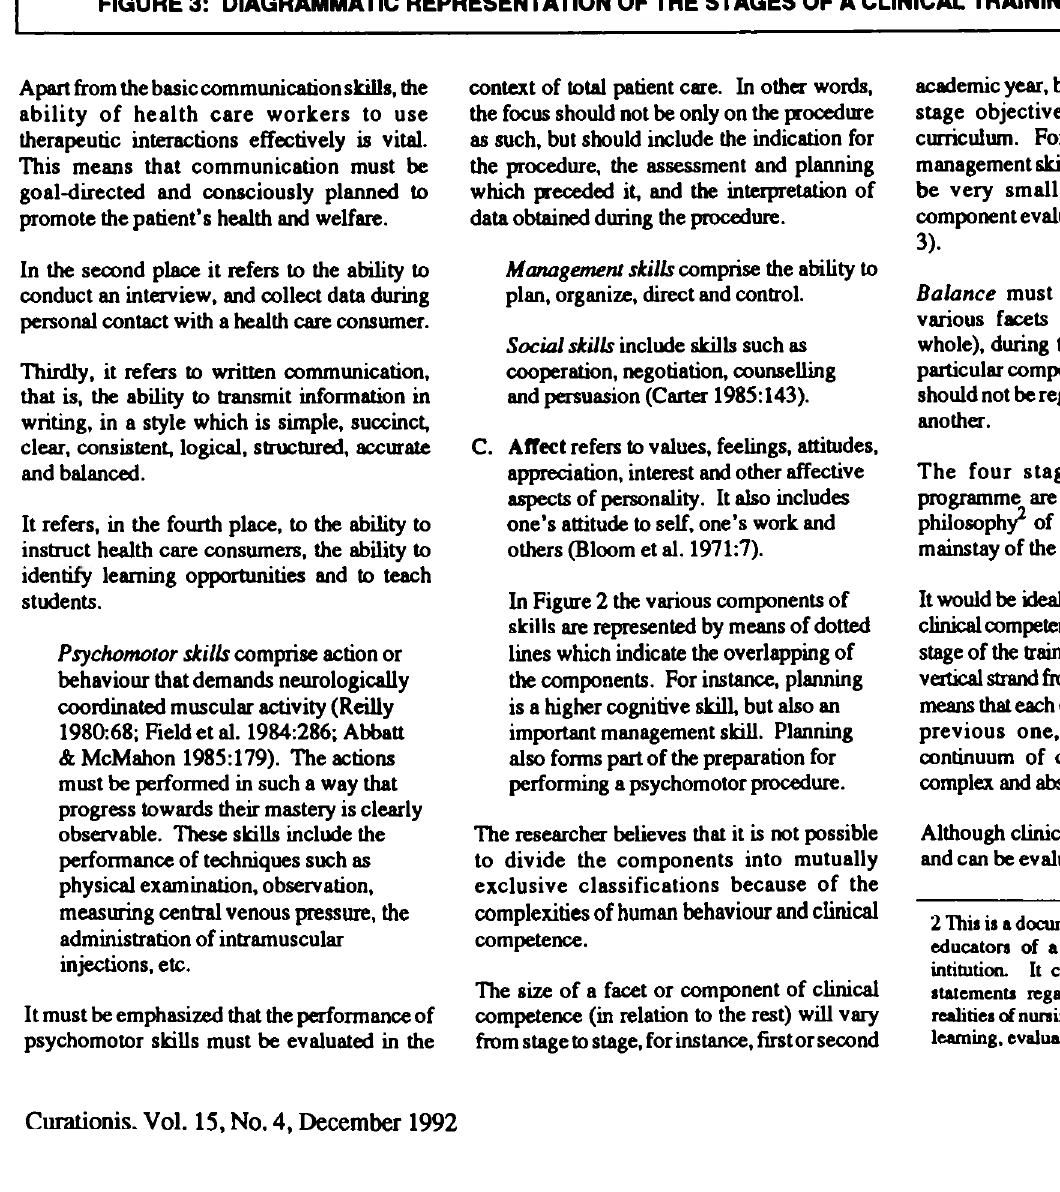
FIGURE 3: DIAGRAMMATIC REPRESENTATION OF THE STAGES OF A CLINICAL TRAINING PROGRAMME